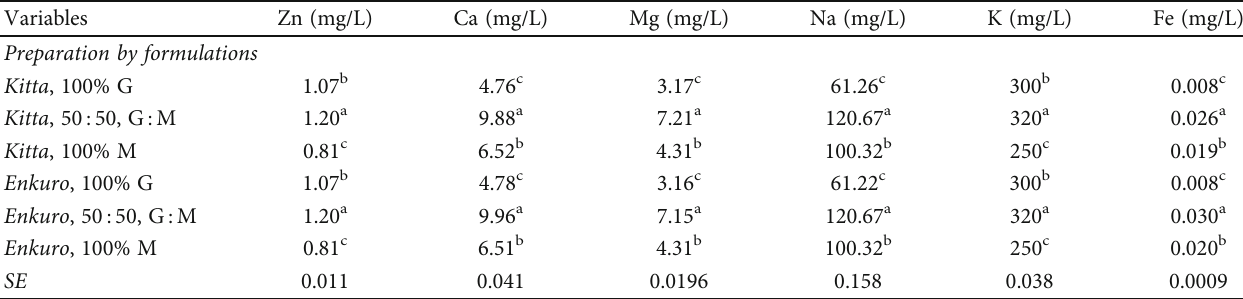
Table 3: Dietary mineral contents of tella samples as in fl uenced by preparation and